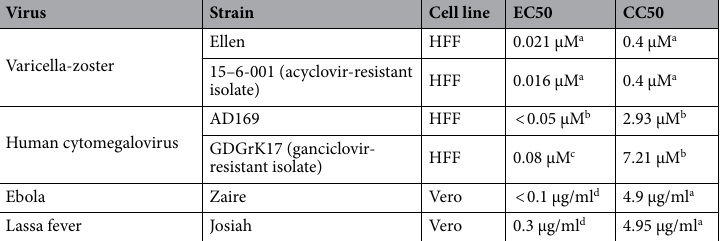
Table 4. Inhibition of multiple viruses by F84T Malay BanLec. Assay used to determination the 50% effective concentration (EC DNA. d Crystal violent plaque